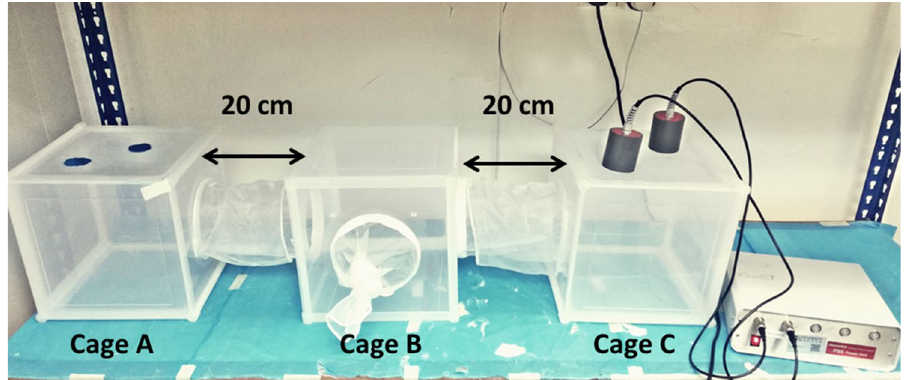
Figure 6. The triple cage setup to study the meal preference of the An. cracens